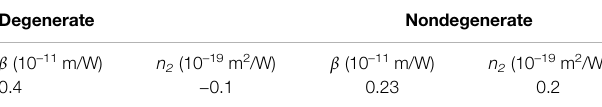
TABLE 1 | Bound electrons-related nonlinear optical parameters. β , TPA coef fi cient; n2, Kerr refractive index. Degenerate Nondegenerate